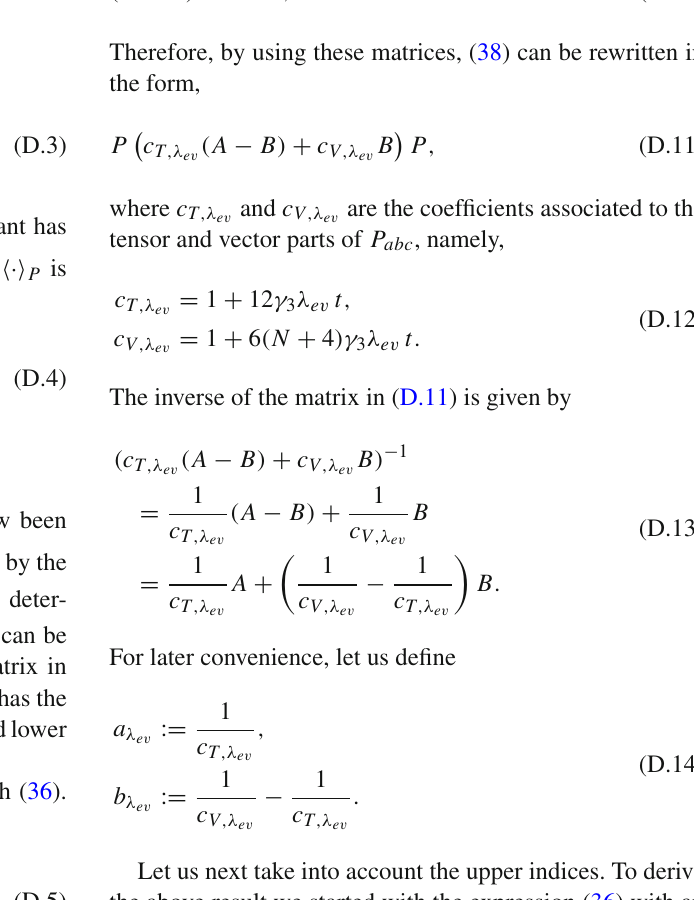
Fig. 9 Graphical representations of the matrices A and ˜